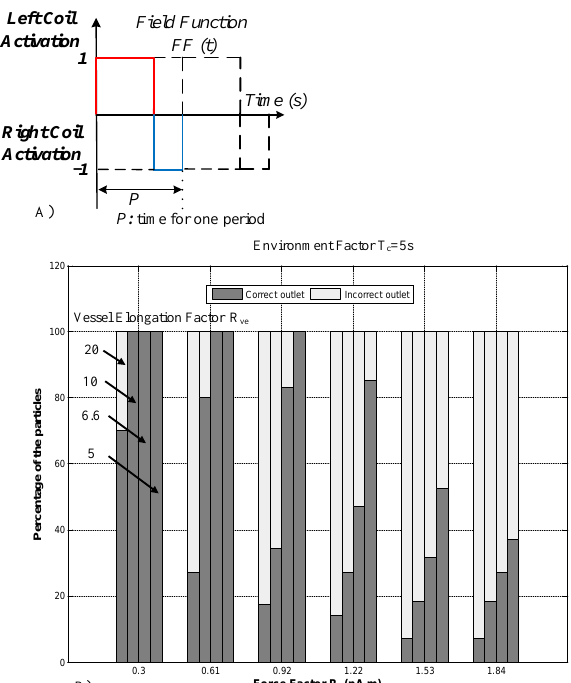
Figure 4. Simulation results for aggregated particle guidance. ( A ) The field function for magnetic actuation. ( B ) The delivery performance in a simulation of a Y-shaped vessel with d v = 1 mm, L v = 10 mm, T n = 5 s and field function ( FF )( t ) with 6 A and duty cycle of 0.5